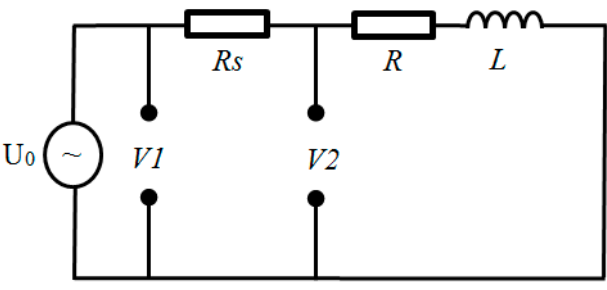
Figure 13. Equivalent measurement circuit of measure coil parameters ( L, R ).